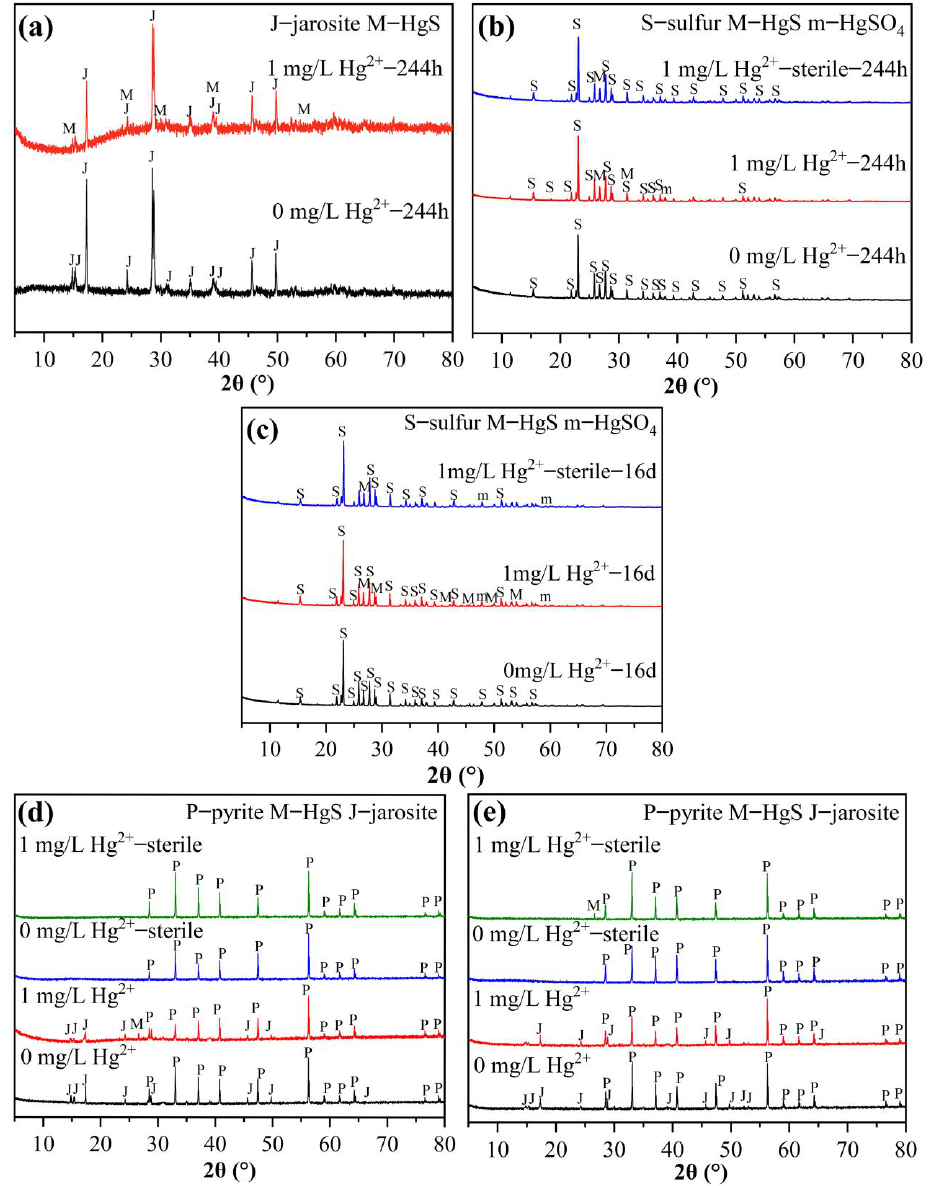
Figure 5. XRD images of bacterial cells of A. ferrooxidans ATCC 23270 in the presence of Hg 2+ . ( a ) Fe 2+ oxidation; ( b ) S 0 oxidation; ( c ) anaerobic Fe 3+ reduction coupled with S 0 oxidation; ( d ) the aer-